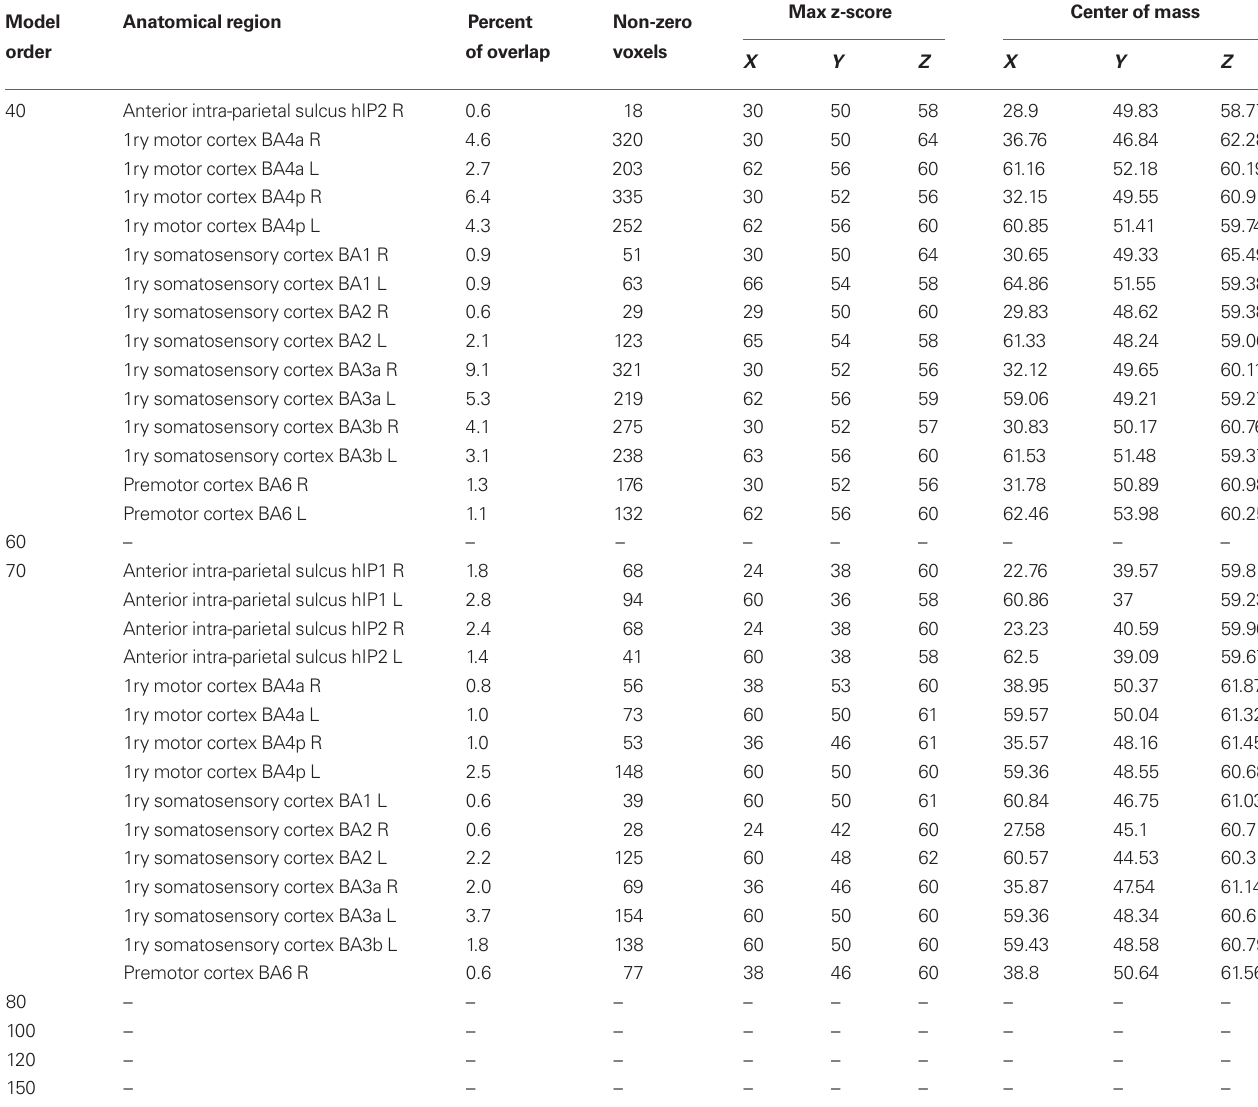
Table 5 | SAD functional connectivity differences in the motor cortex at all estimated ICA model